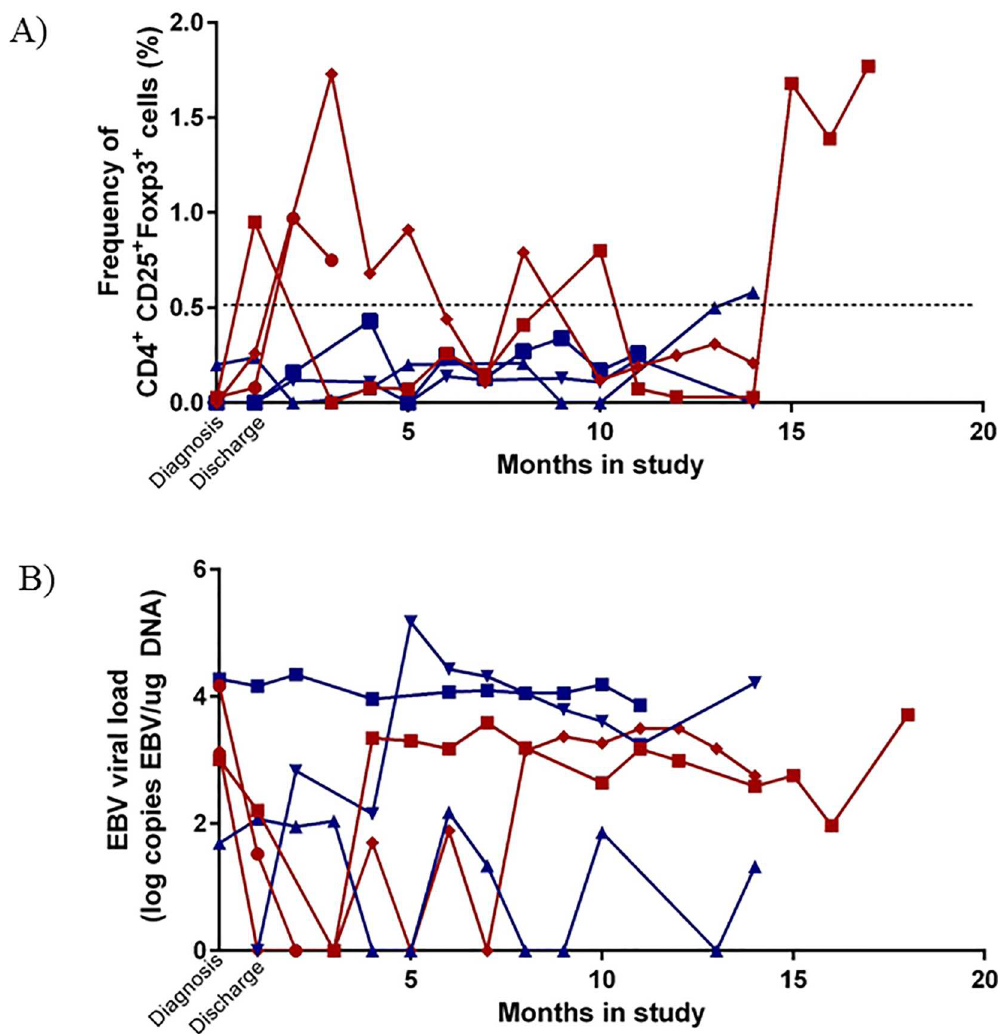
Fig 3. Elevated Treg frequencies in patients prior to relapse. Frequencies of CD25 + Foxp3 + Treg cells (A) and EBV viral load (B) at monthly follow-uptime points in 3 event-free survivors and 3 patients who relapsed. Proposed Treg frequency thresholdindicativeof future relapse was established by measuring Treg frequencies in 8 other event-free survivors4–9 months post discharge, and frequencies never rose above 0.5% (dotted line). Designated as a red ♦ = BL001 (relapse),designated as a red ● = BL002 (relapse),designatedas a red ■ = BL003 (relapse), designated as a blue ▲ = BL004 (event-free survivor), designated as a blue ▼ = BL005 (event-free survivor) designated as a blue ■ = BL006 (event-free